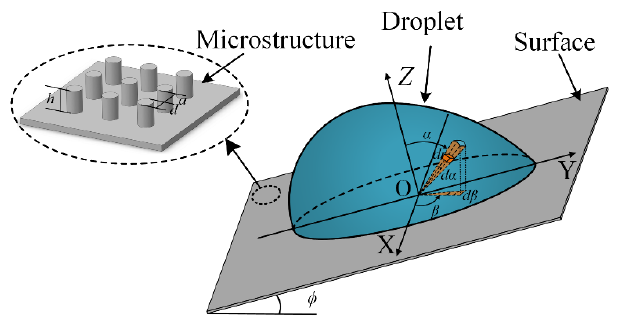
Figure 4. The droplet on the inclined, hydrophilic rough surface.